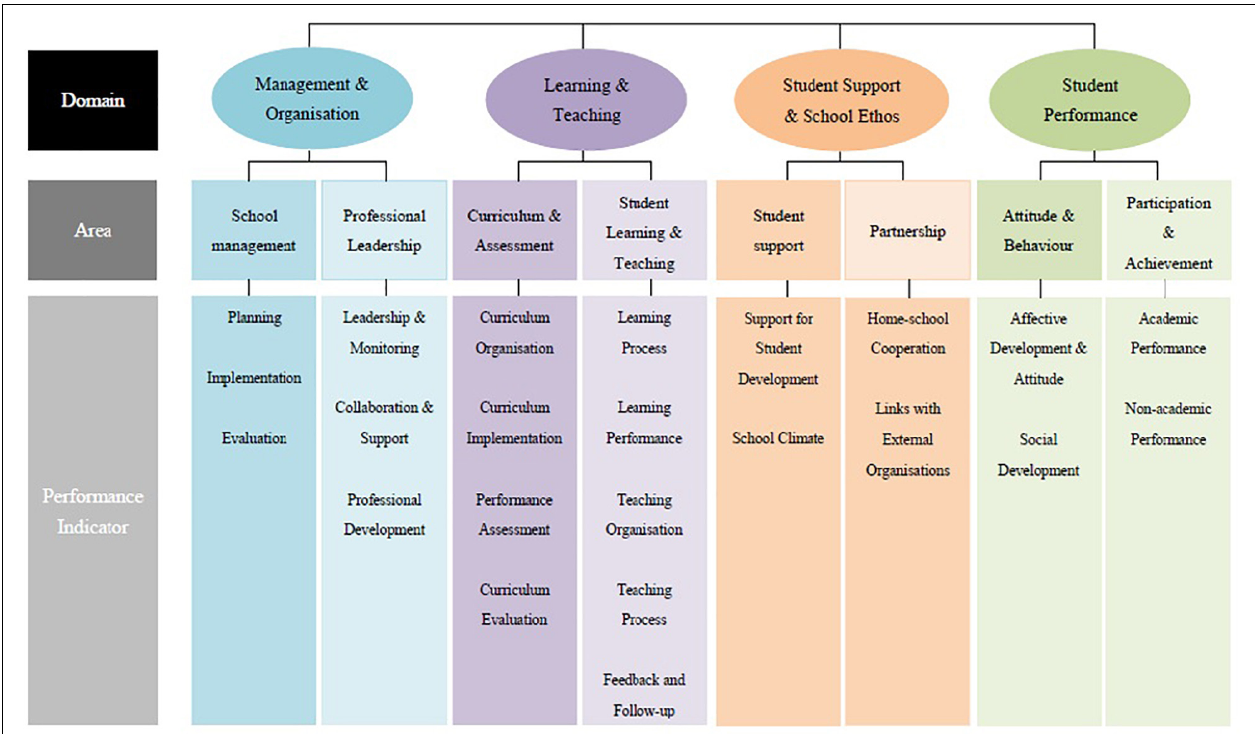
FIGURE 1 | Performance indicators framework. The performance indicators framework is extracted from EDB01, p. 3. It is a three-tier framework, comprising domains, areas, and performance indicators. The government evaluates the effectiveness of schools by focusing on four domains: management and organization, learning and teaching, student support and school ethos, and student performance. Each domain is subdivided into two areas, resulting in eight areas operationalized by 23 performance indicators.